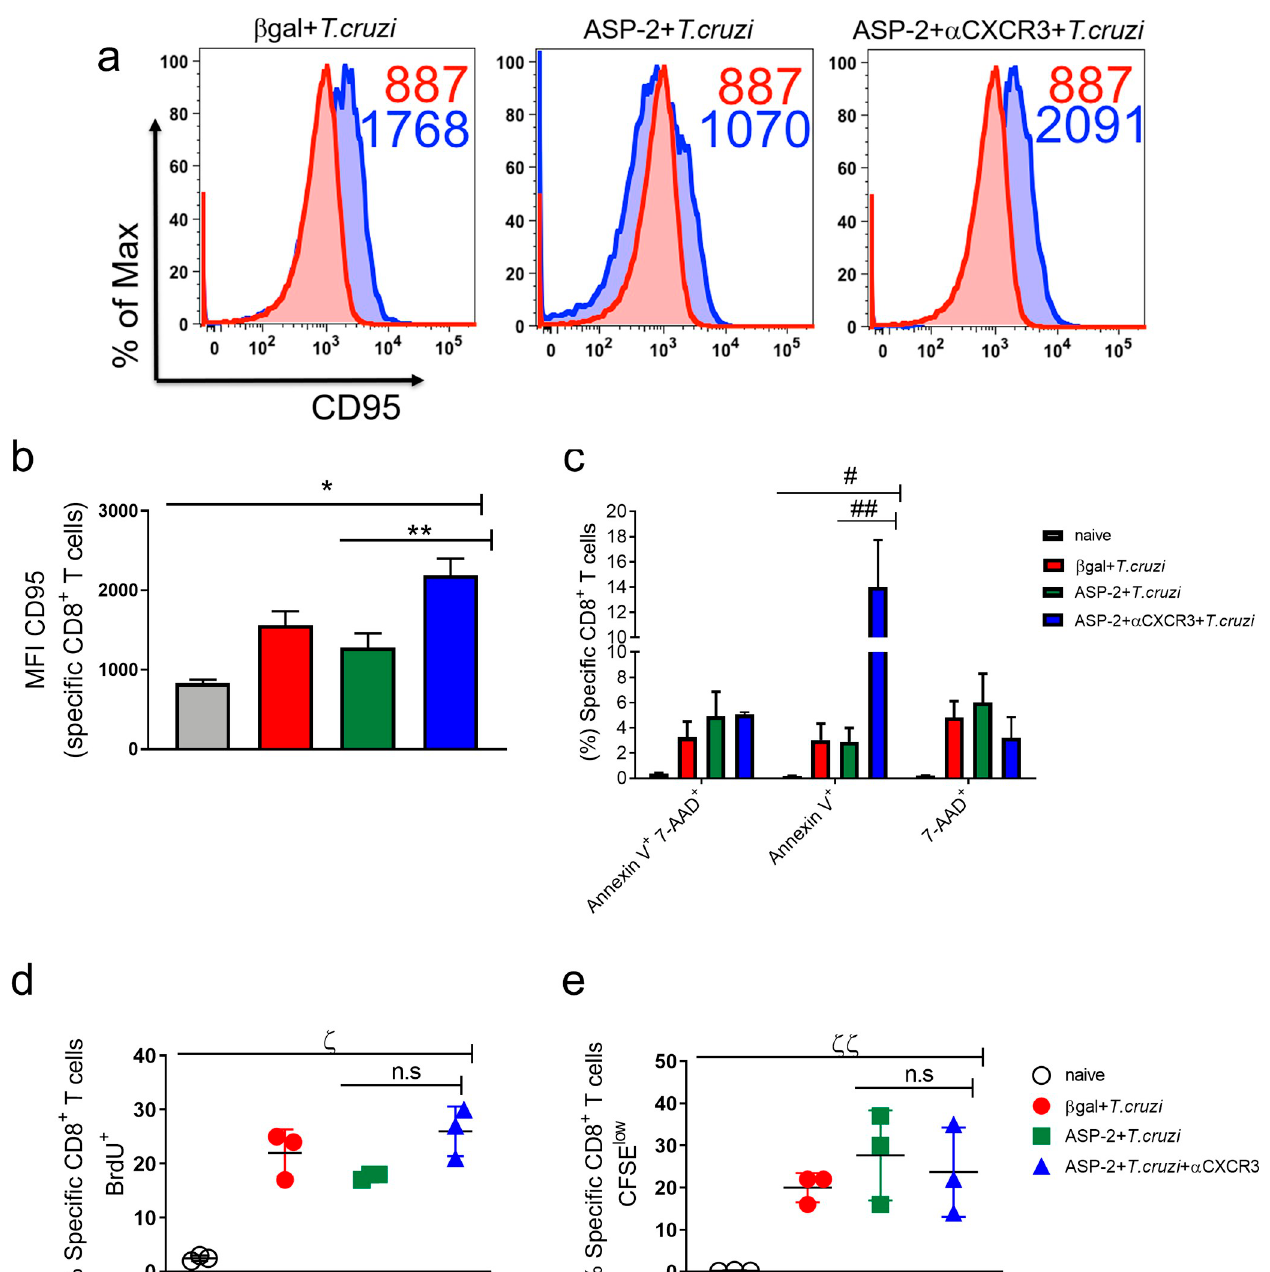
Fig 4. Anti-CXCR3 treatment increased the proapoptotic phenotype of specific CD8 + T cells, but those cells could proliferate. Specific CD8 + T cells from β gal+ T . cruzi ,ASP2+ T . cruzi , and ASP2+ α CXCR3+ T . cruzi groups were labeled to check proapoptotic profile. a-Histograms represent the MFI of CD95 (Fas) molecule on specific CD8 + T cells surface (from spleen). The red histogram represents the na ï ve group and the blue are: β gal+ T . cruzi , ASP2+ T . cruzi and ASP2+ α CXCR3+ T . cruzi groups. b-Bar graph shows the average of CD95 MFI on specific CD8 + T cells. c- Boolean analysis with the frequency of specific CD8 + T cells positive for annexin V + and/or 7-AAD + . d-The percentage of specific CD8 + T cells that incorporated the BrdU molecule. The BrdU administration was done in the same day after infection (2mg of BrdU, via i.p route) and every 48 hours until 20 days after infection. e-Percentage of specific CD8 + T cells expressing CFSE low . The splenocytes from β gal+ T . cruzi ,ASP2+ T . cruzi and ASP2+ α CXCR3+ T . cruzi groups were labeled with CFSE and stimulated for 5 days with TEWETGQI peptide. Afterword the specific CD8 + T cells were labeled with H2K k -TEWETGQI dextramer. Results are shown as individual values and as the mean ± SEM for each group (n = 3). Statistical analysis was performed using the One-Way ANOVA and Tukey’s HSD tests. Symbols indicate that the values observed were significantly different between the groups ( � p < .0001; �� p < .01; # p < .0001; ## p < 0.01; z p < .0001 and zz p = 0.0105) and n.s means no